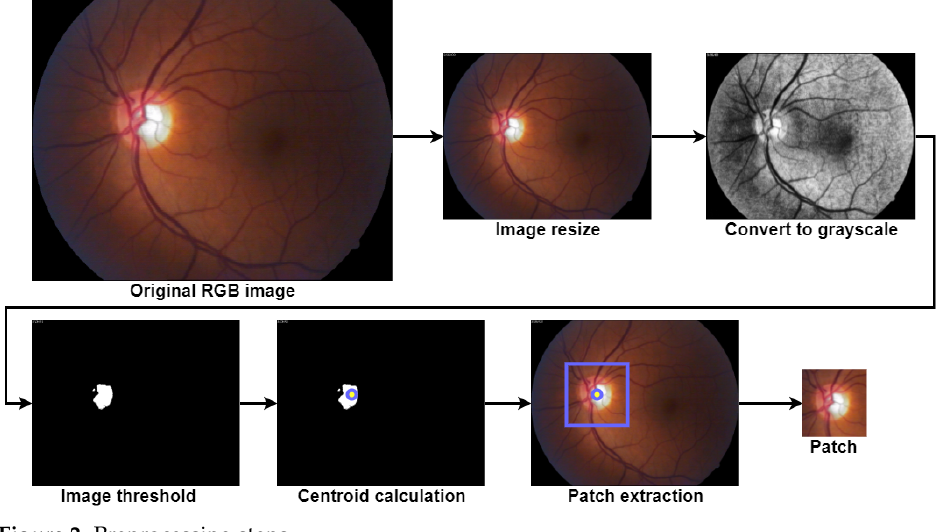
Figure 2. Preprocessing